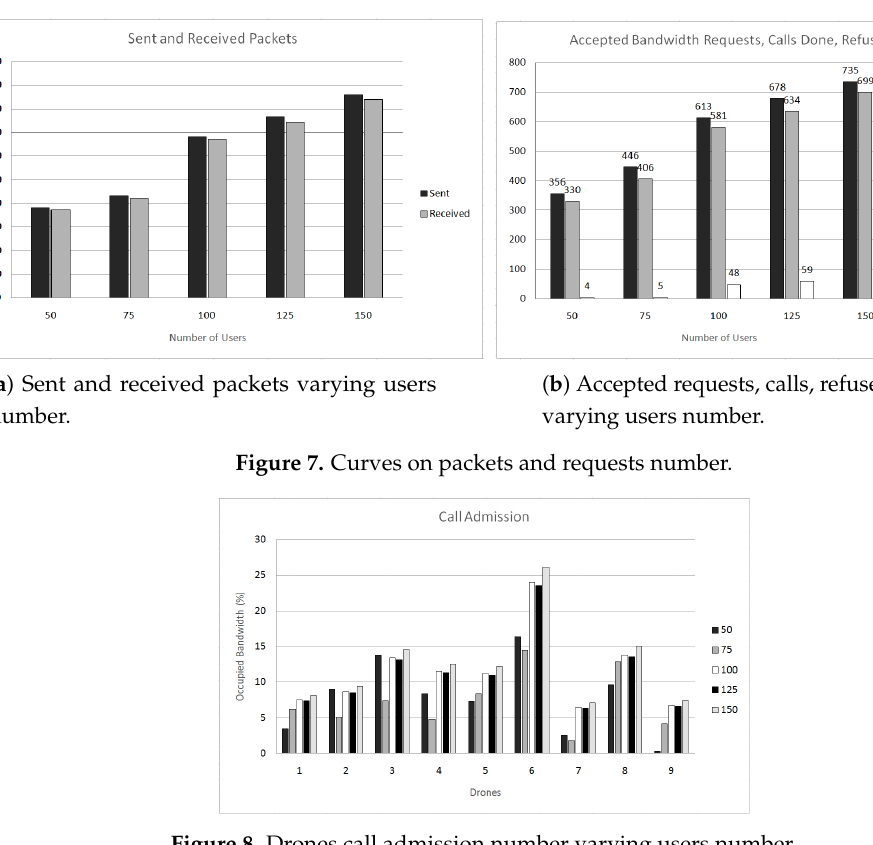
Figure 8. Drones call admission number varying users